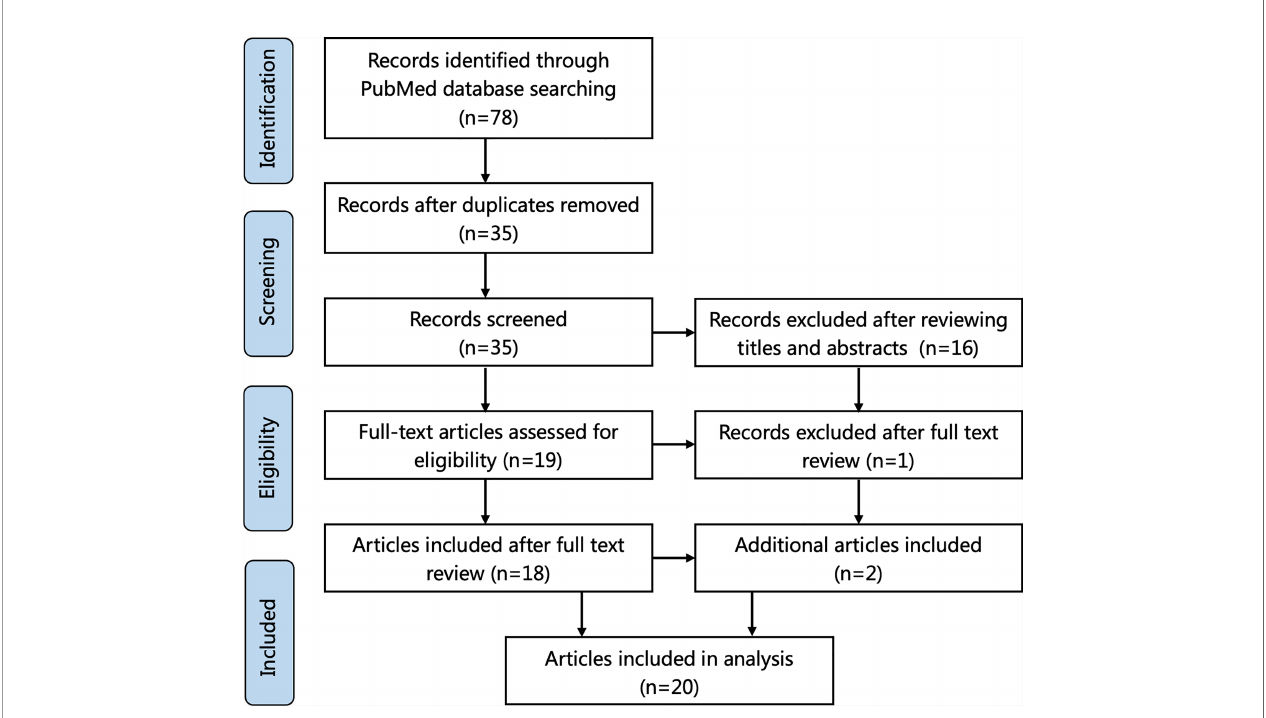
FIGURE 1 | Flowchart of literature selection using the PRISMA